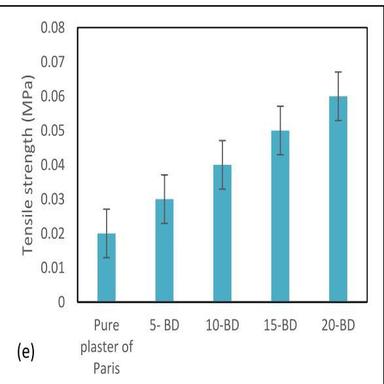
Physico-chemical properties (a) density (b) compression strength, (c) water absorption, (d) thermal conductivity, and (e) tensile strength.